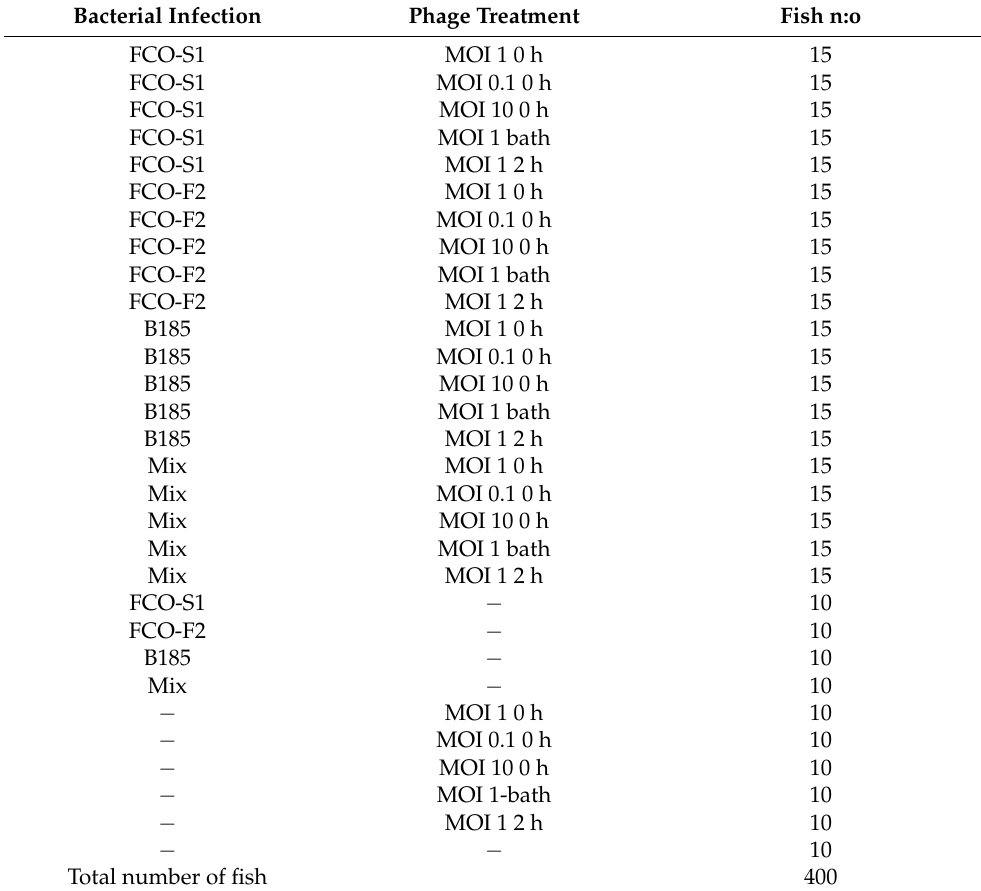
Table 3. Setup of experiment II. Rainbow trout fry were infected individually with three Flavobac- terium columnare isolates (FCO-S1, FCO-F2, and B185) (5 × 10 3 CFU mL − 1 ) and their mix. For phage-treatment, a phage mix of three phages (FCOV-S1, FCOV-F27, and FCL-2) was added at MOI 1, 0.1, or 10 at the same time (0 h) or at MOI 1, 2 h after adding the bacteria. One group of fish was bath-exposed for 2 h to the phage mix (MOI 1) before transferring to experimental aquaria and adding the bacteria. − = Shieh medium added instead of bacterium and/or phage. Bacterial Infection Phage Treatment Fish n:o FCO-S1 MOI 1 0